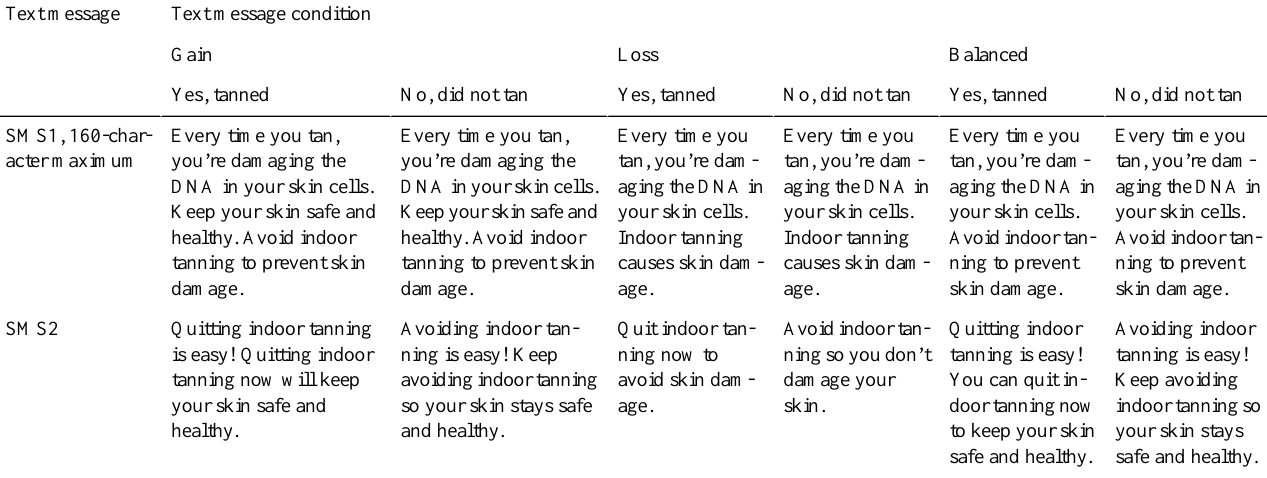
Table 1. Examples of initial (SMS1 a ) and follow-up prompt (SMS2) indoor tanning prevention text messages for day 1 (of 7 days), by message framing condition (gain-, loss-, or balanced-framed), based on whether a participant answered “yes” or “no” to whether they had indoor tanned that